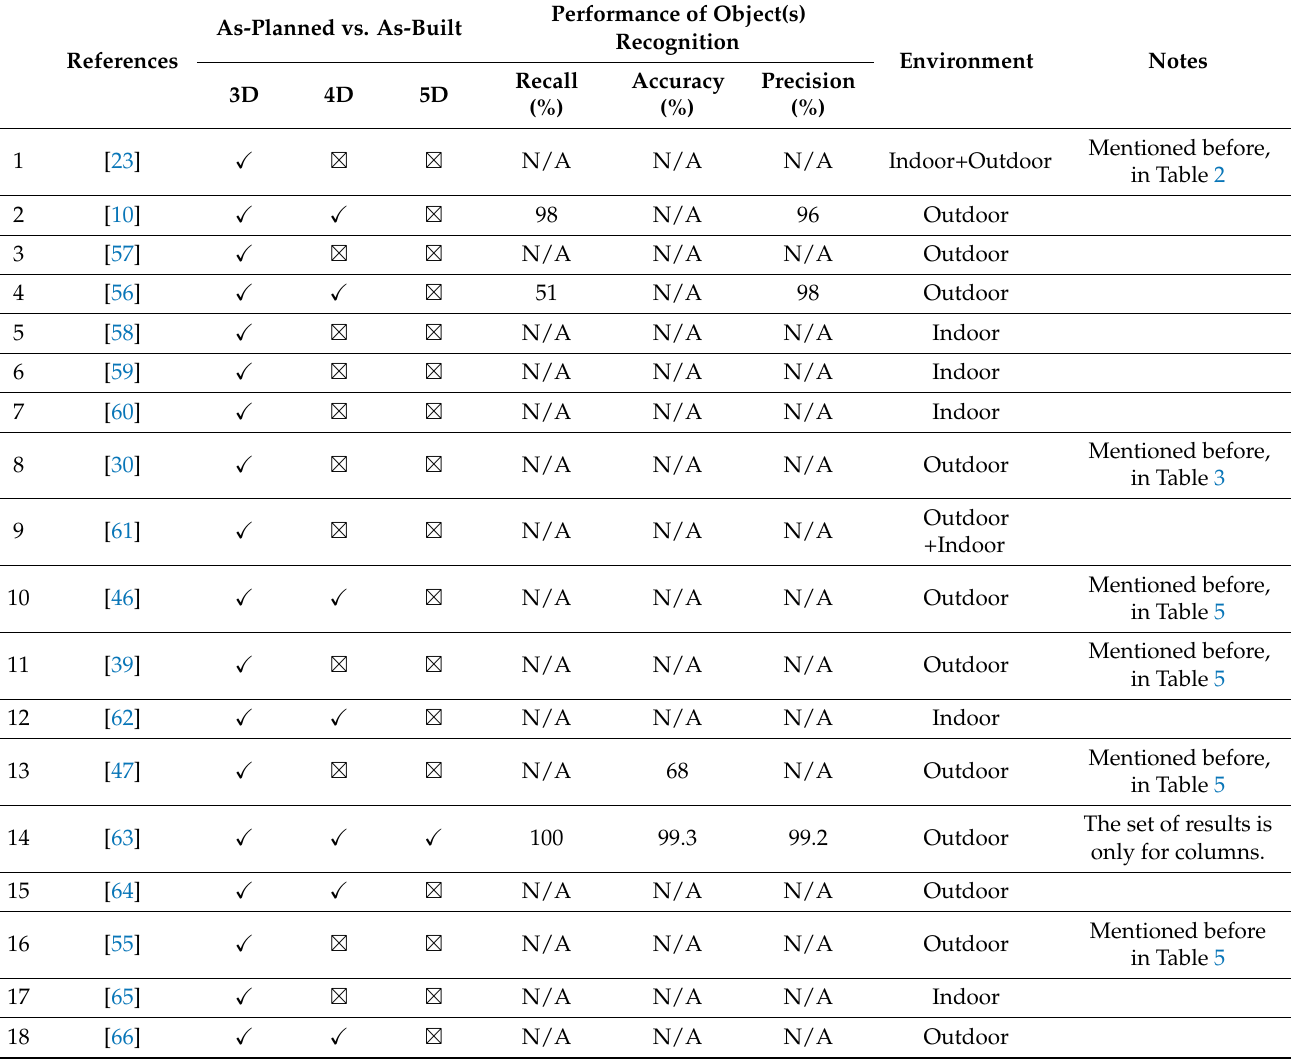
Table 6. Studies of laser scanning integration with BIM in CPM: 2007–2021. As-Planned vs.